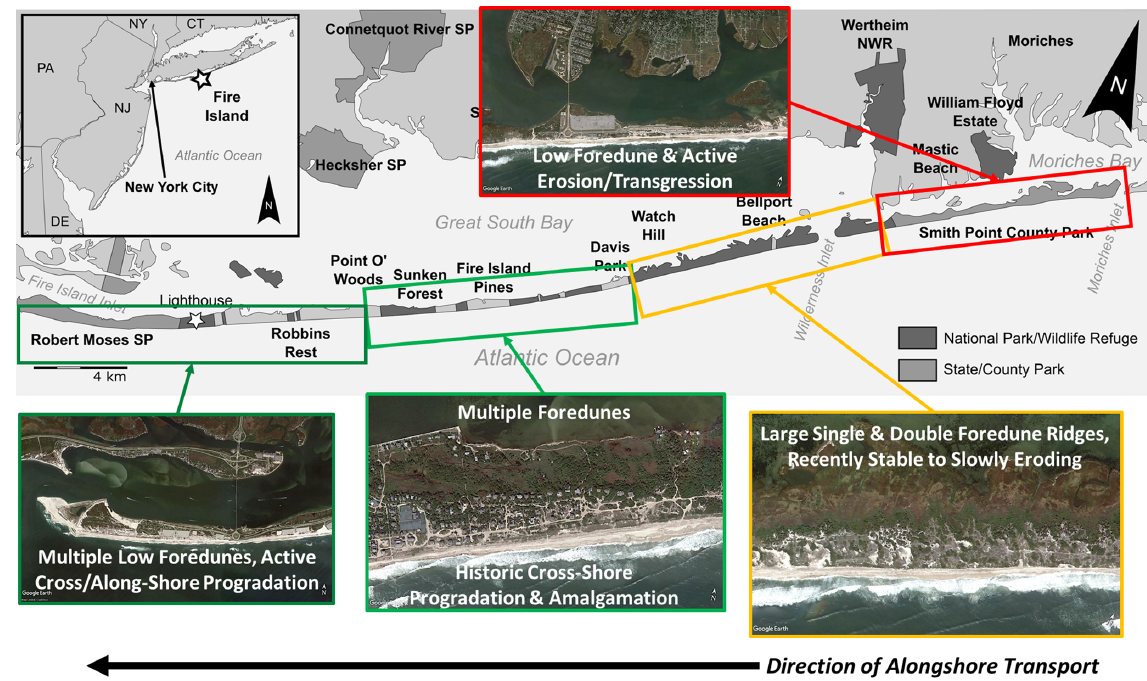
Figure 14. Overview of Fire Island alongshore sediment transport gradient, with the updrift (eastern) end of the island displaying low, overwashed transgressive morphology and downdrift (western) end of island showing multiple beach ridges and a spit extension typical of distal accretion. The inset shows the location of Fire Island within the coastal Mid-Atlantic US region. Green outlines correspond to regions characterized by present and/or historical progradation and cross-shore amalgamation, yellow outlines correspond to those characterized by aggradation or slow erosion, and red outlines correspond to those characterized by erosion or migration. Map data © Google Earth, Landsat/Copernicus